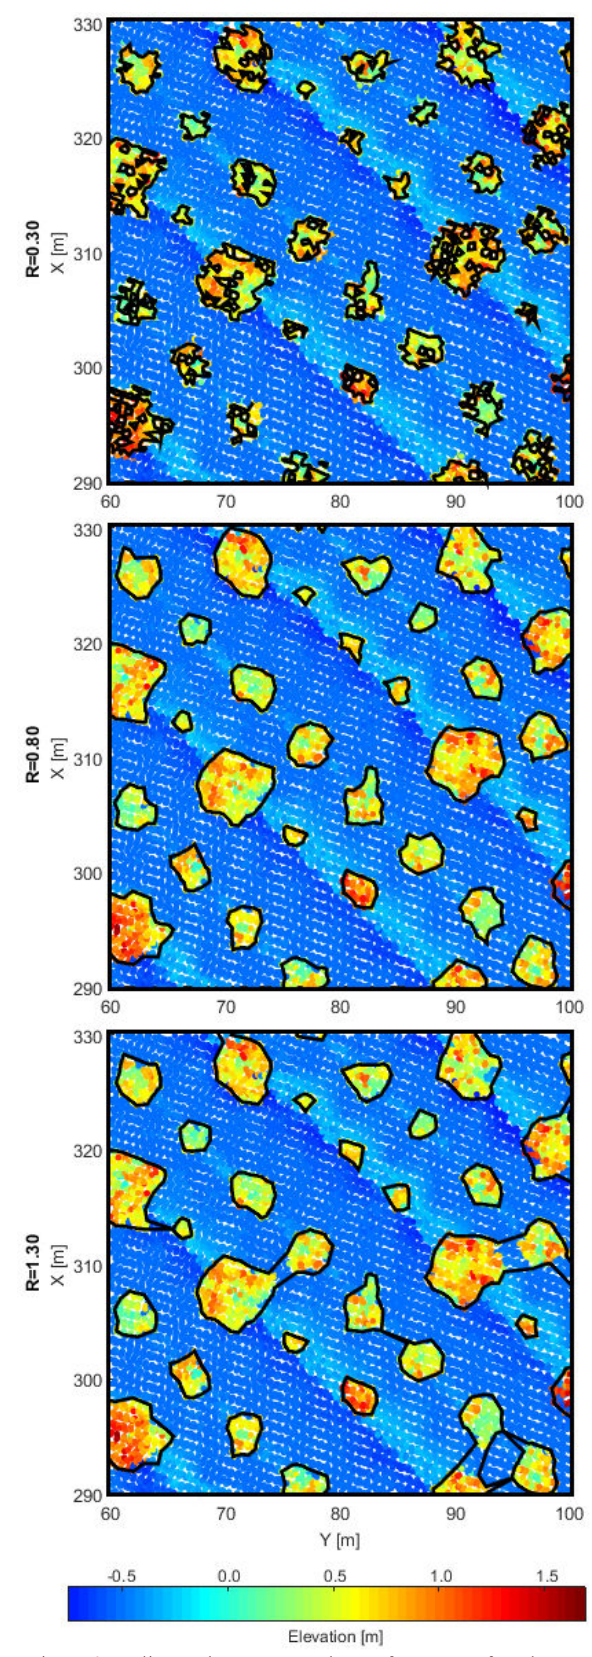
Figure 2. Delineated tree crown shapes for a part of study area for exemplary value of R ; point cloud in the background coloured by point elevation